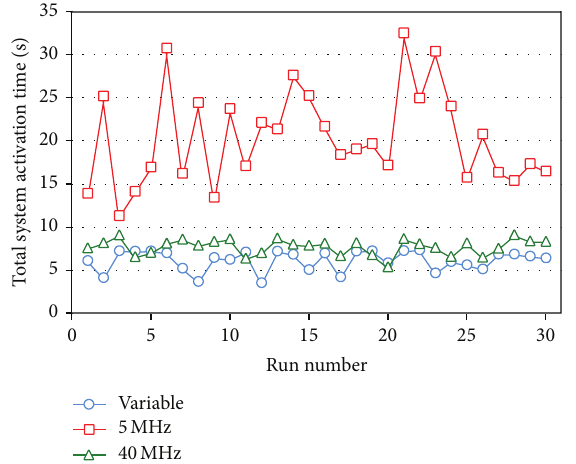
Figure 13: Line chart of the experiment result of transmitting 10 sessions in networks with different numbers of